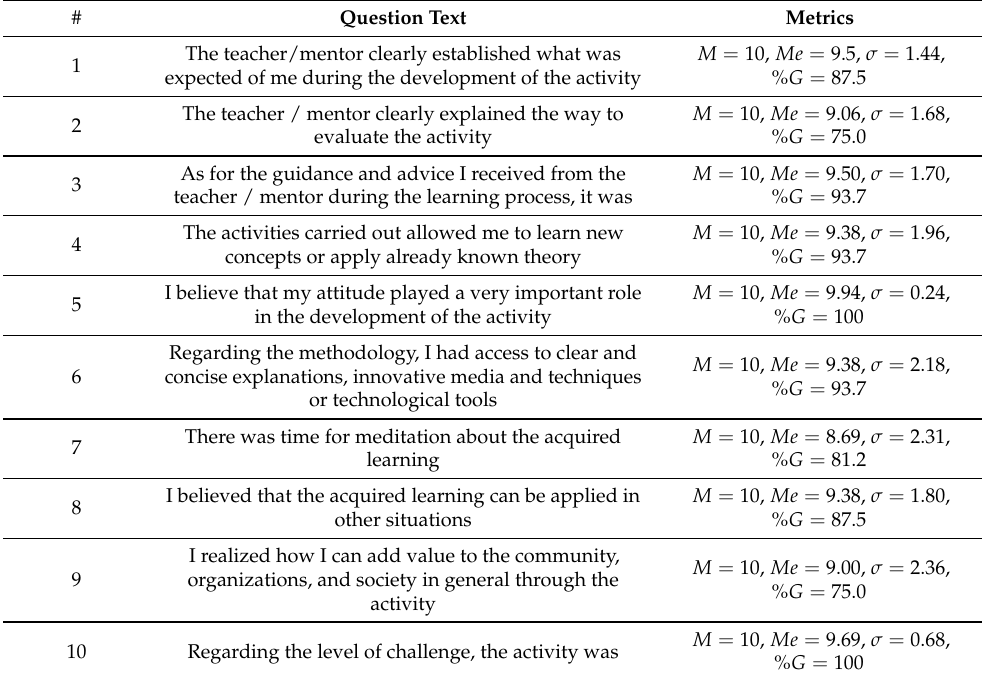
Table 5. Mode ( M ), mean ( Me ), standard deviation ( σ ), and the percentage of “good” opinions ≥ 8.0 (% G ) for the first ten closed-ended students’ survey questions.